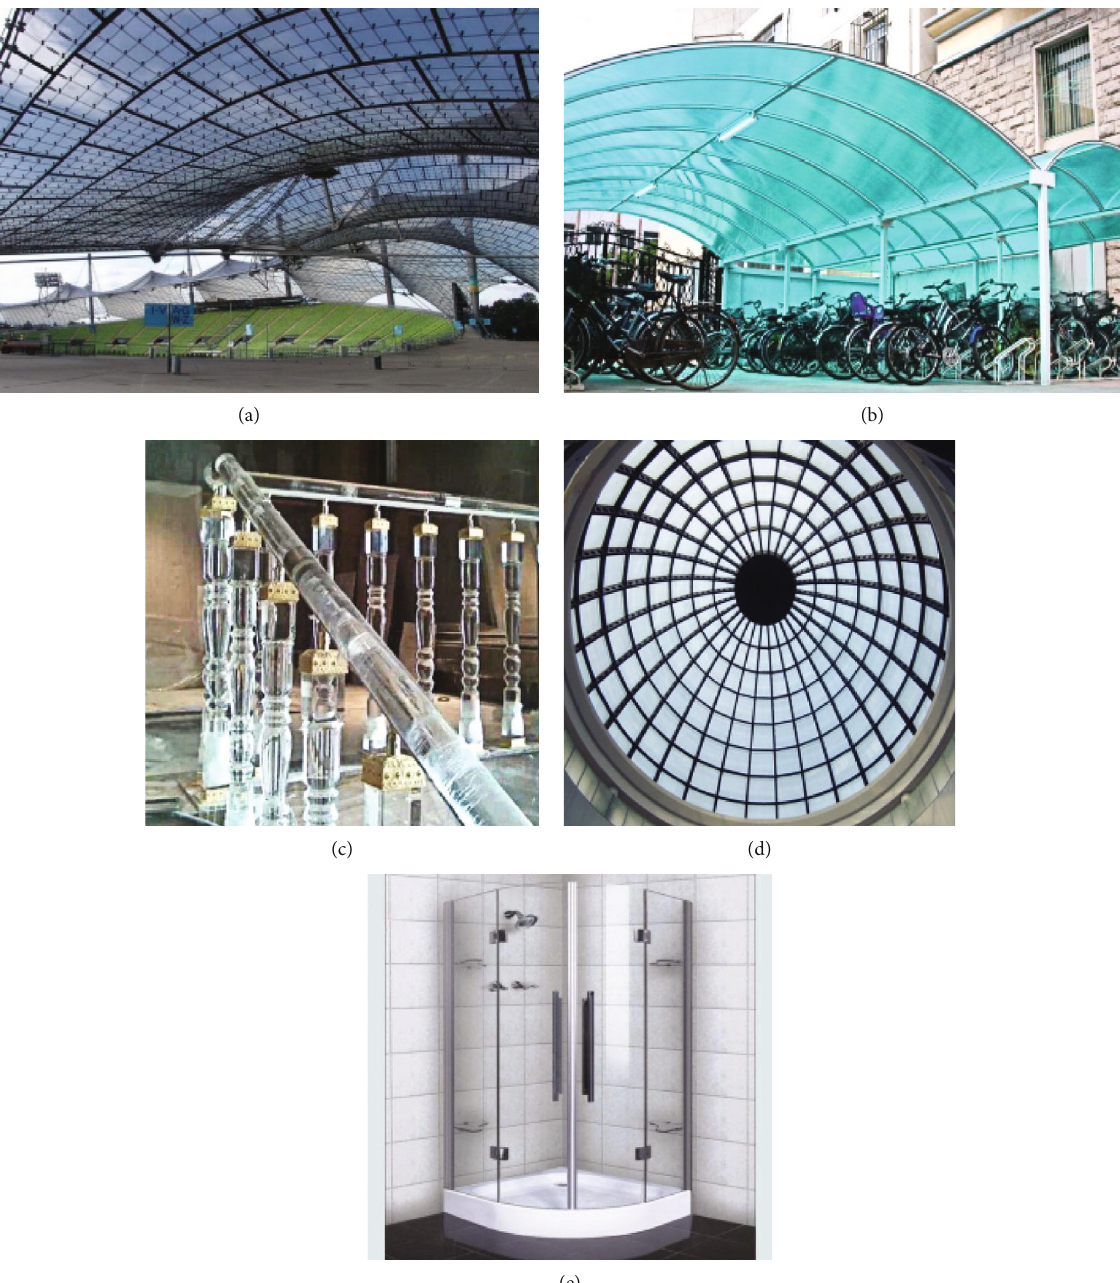
Figure 4: Applications of PMMA in construction and buildings. (a) Stadium for the 20th Olympic Games in Munich, Germany. (b) PMMA sun board shed. (c) Cylindrical PMMA stairs. (d) PMMA pyramid of light shade roof skylight glass. (e) Cylindrical PMMA component